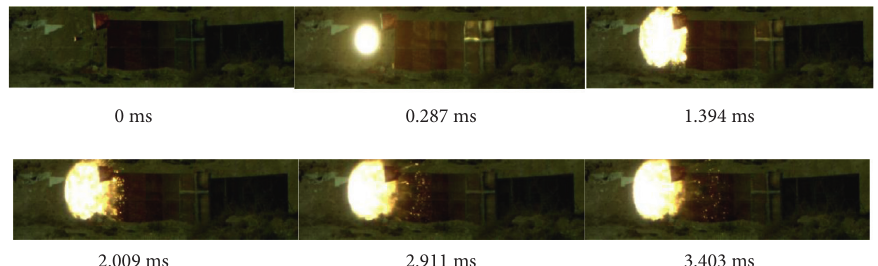
Figure 5: Evolutions of warhead explosion attitude and fragment flying trajectory: 0 ms, 0.287ms, 1.394ms, 2.009ms, 2.911ms, and